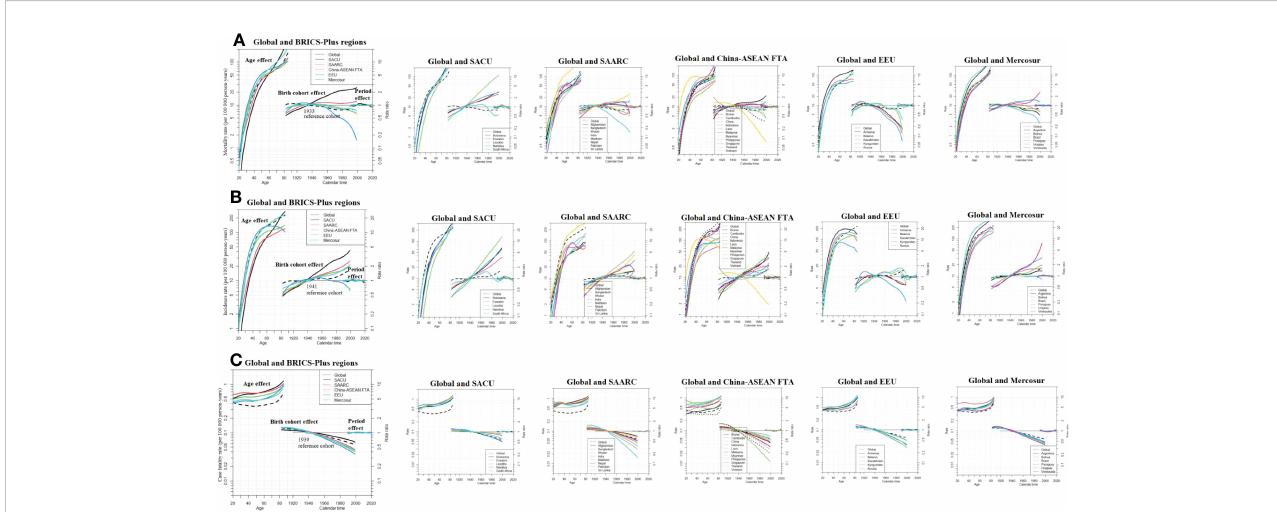
FIGURE 5 Age period cohort related female breast cancer trends in (A) death rate (B) incidence rate and (C) case fatality rate (CFR) from 1990-2019 with ages 20 to 84. Rate ratio was estimated using ML of APC-model Poisson with log(Y) based on natural-spline function, for each BRICS-Plus region separately. ML, maximum likelihood; APC, age-period-cohort; Reference cohort for age-effects was chosen as the median date of birth among cases; and Median date of diagnosis among cases was selected as reference period; SACU, South African Customs Union; SAARC, South Asian Association for